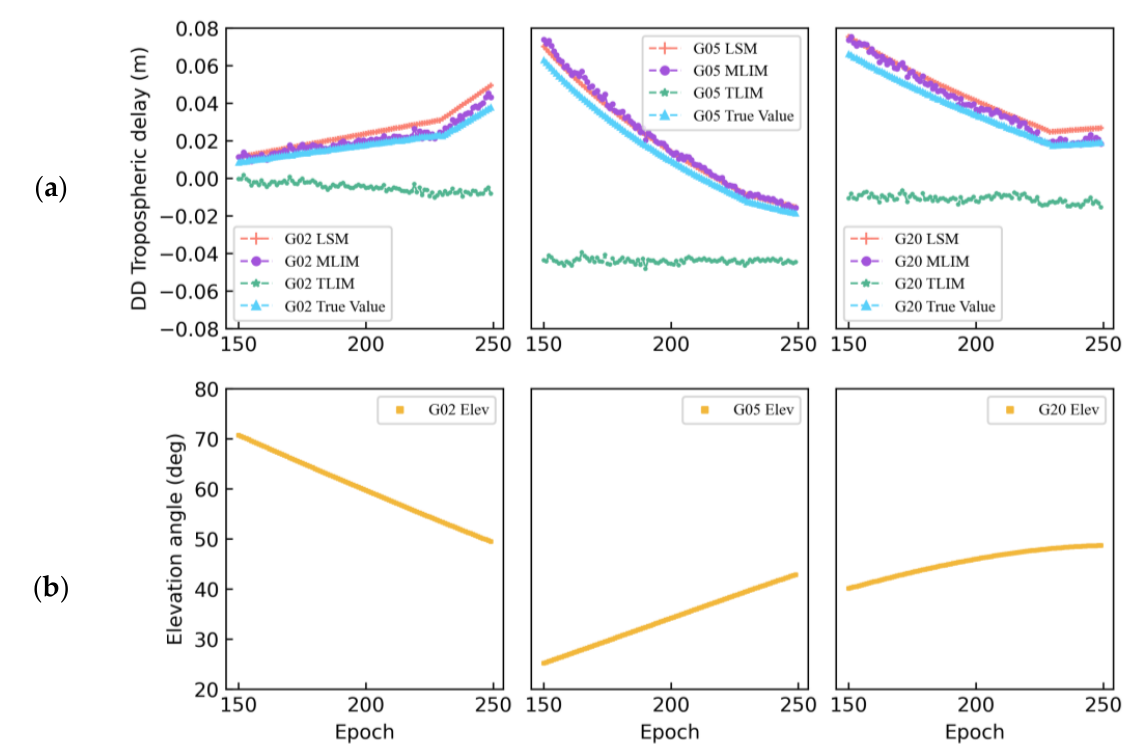
Figure 4. Comparison of the DD tropospheric delay interpolated by different methods ( a ) and the satellite elevation variation of G02, G05, and G29 ( b ).